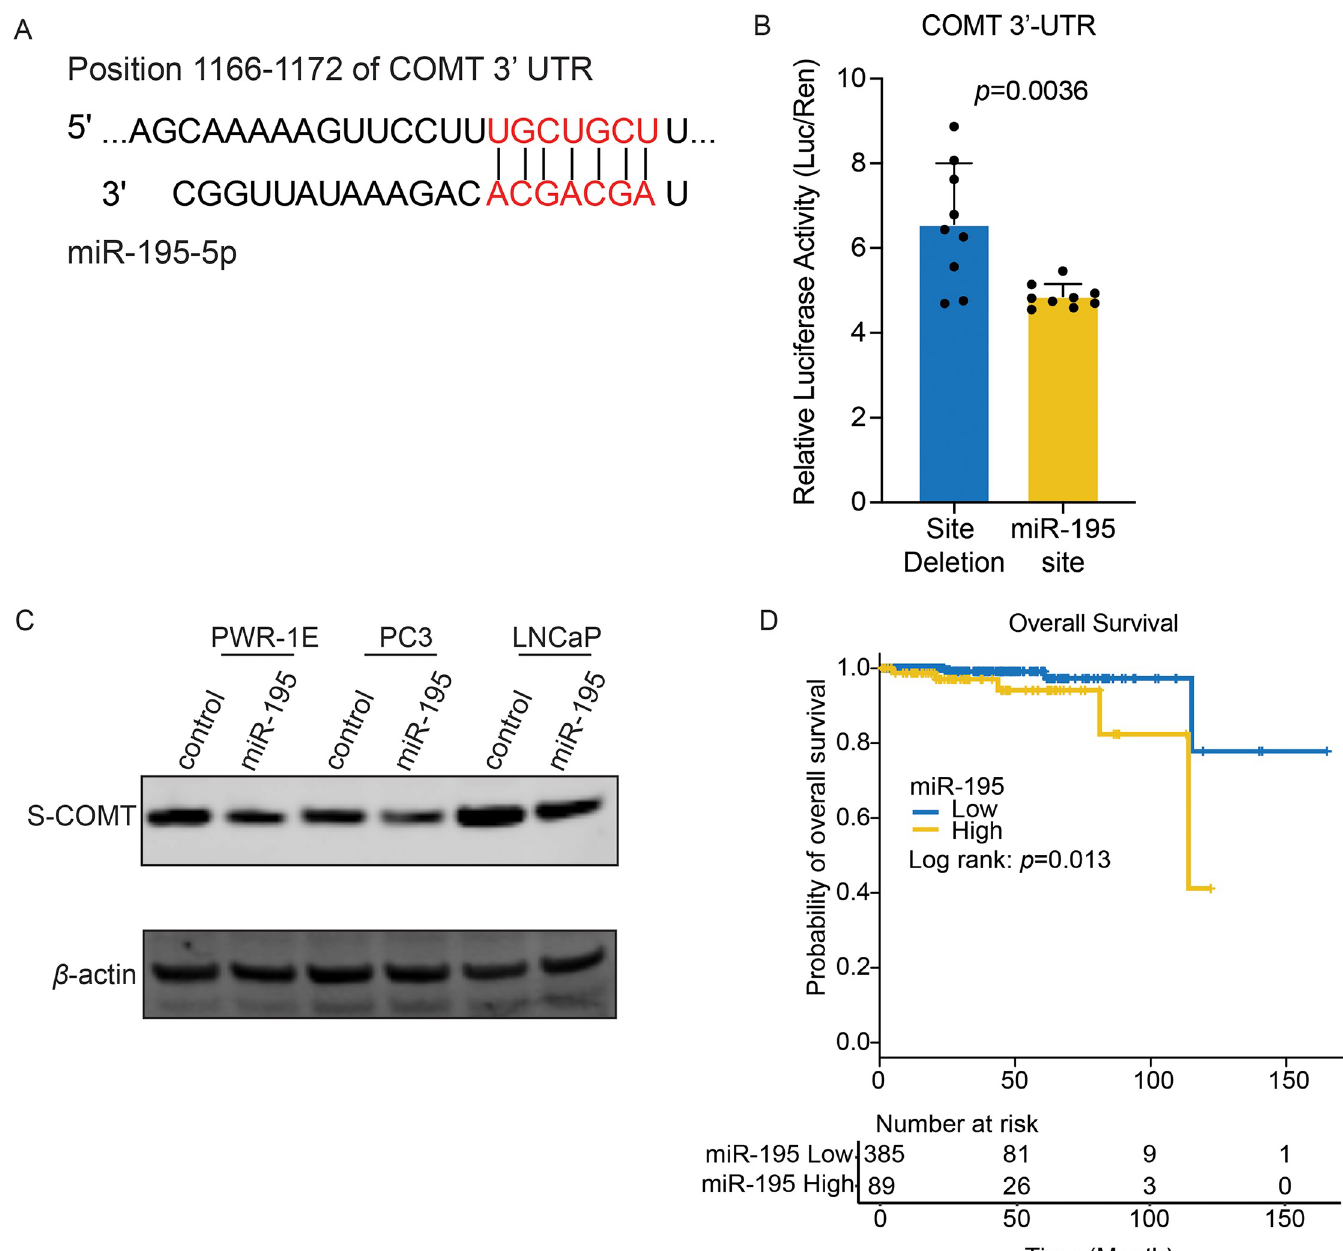
Fig 6. Regulation of COMT by miR-195. (A) MiR-195 binding site on the COMT gene 3’-UTR were predicted by TargetScan. (B) Luciferase assay show miRNA-195 capable of targeting COMT. Luciferase activity of constructs of COMT sequences consisting of miR-195 binding site or its deletion were compared in the presence of miR-195 mimics. (C) Overexpressing miR-195 with mimic decreased COMT expression in PWR-1E, LNCaP and PC3 cells by western blot. β -actin used as loading control. (D) Overall survival analysis of miR-195 shows significantly poor survival rate in miR-195 high expression group (Log rank test: p = 0.013). Data are presented as mean ± SD. The p -value is based on paired t-test in